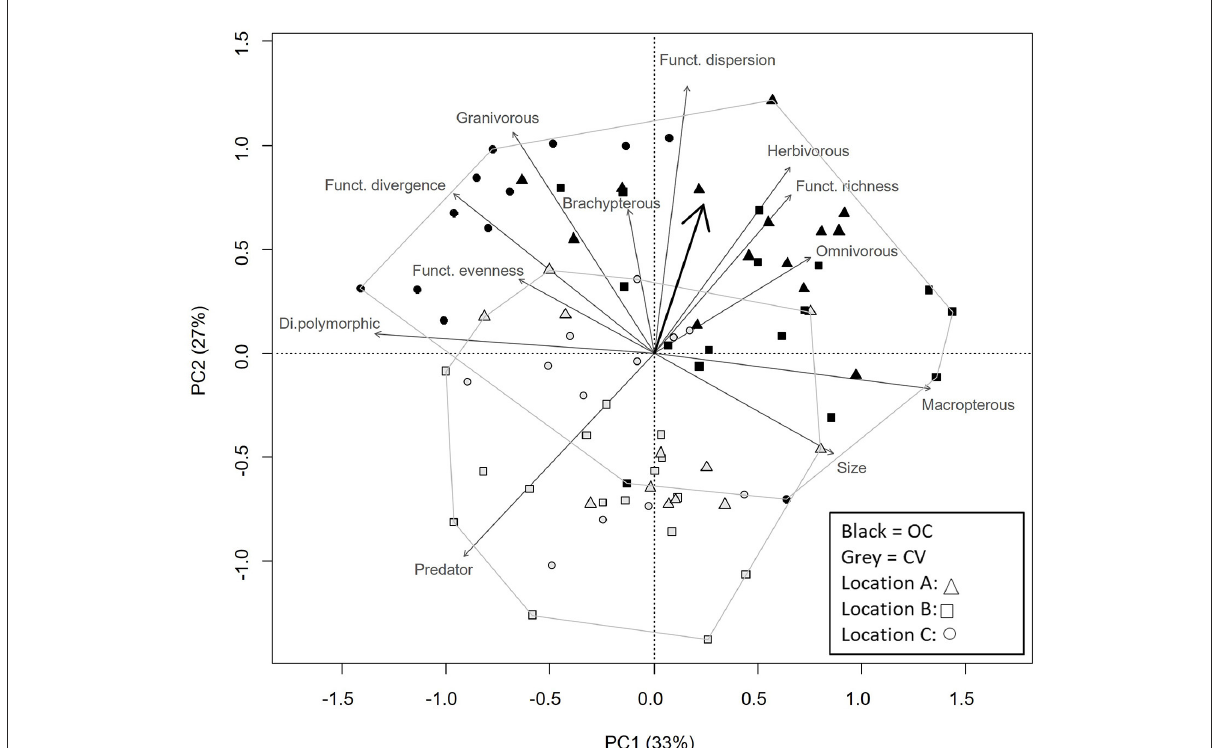
FIGURE4 Principal Component Analysis of CWM-traits attributes and functional diversity indices of carabids community in organic-conservation (black) and conventional (gray) parcels. Shapes indicate the three sampling locations as detailed in legend box. CWM- traits included are: regime (herbivore, granivore, omnivore, predator); wing system type (di- and poly-morphic, macropterous, brachypterous); mean body size. The black arrow depicts the system variable, allowing interpretation between trait attributes and farming system type. Each system type is surrounded to help